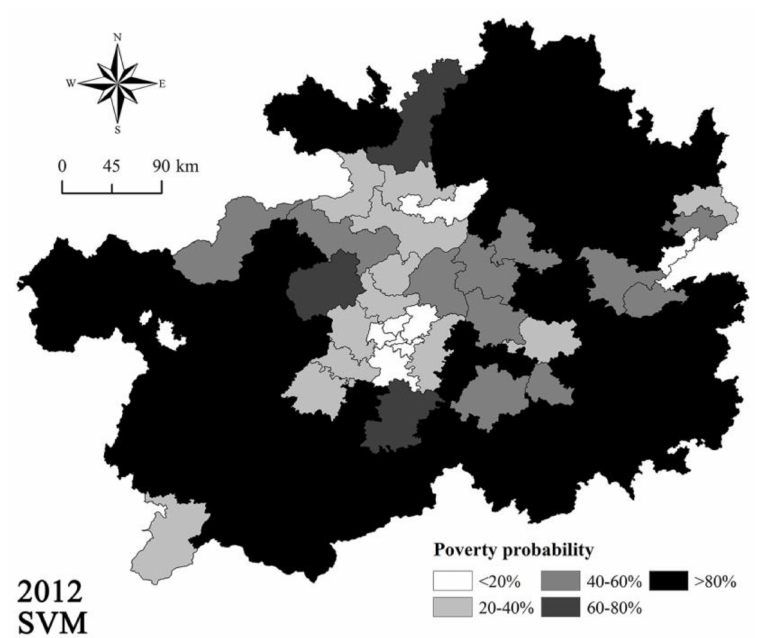
Figure 3. Distribution of poverty probability at the county level by Support Vector Machines (SVM) in 2012.